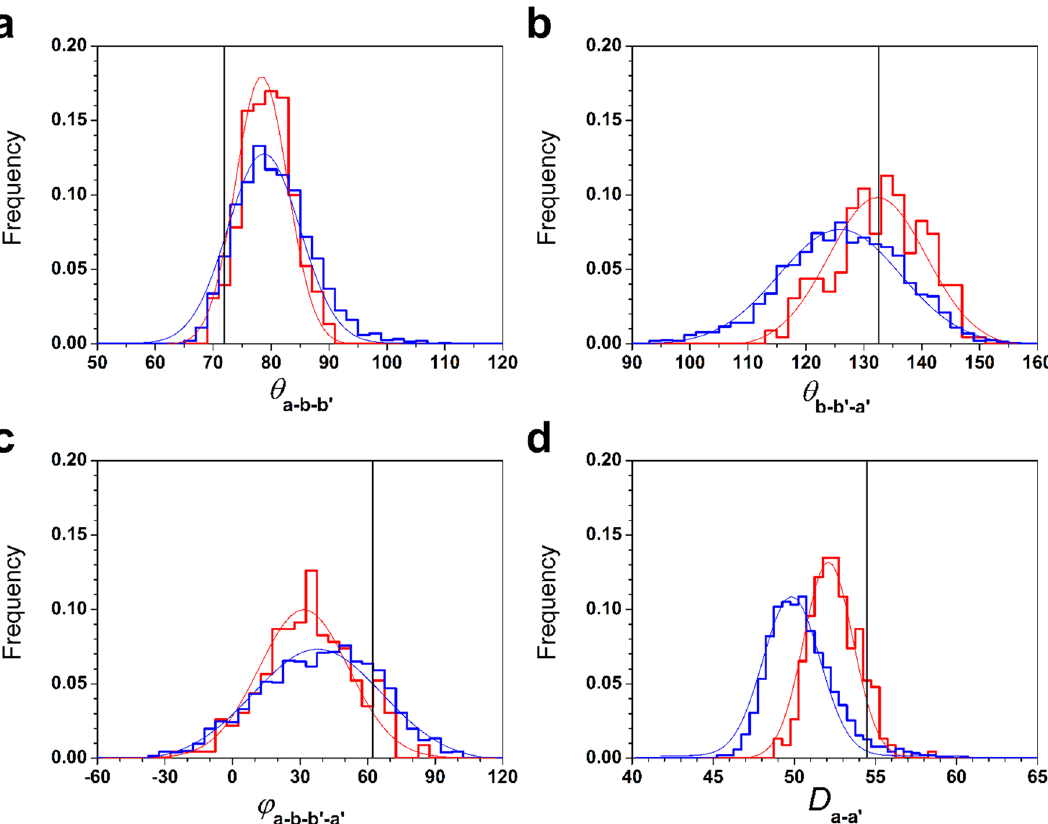
Figure 3. Structural analysis of the ER-60 models. Distributions of θ a–b–b ′ ( a ), θ b–b ′ –a ′ ( b ), and φ a–b–b ′ –a ′ ( c ), and the D a–a ′ ( d ) are shown with red and blue histograms. The frequency is the fraction of the count in each bin divided by the total number of models. The values of the crystal structure are also shown by black lines. Histograms were fit by Gaussians for visibility. The eye-guide curves are shown with red and blue lines for ox- and red-models,